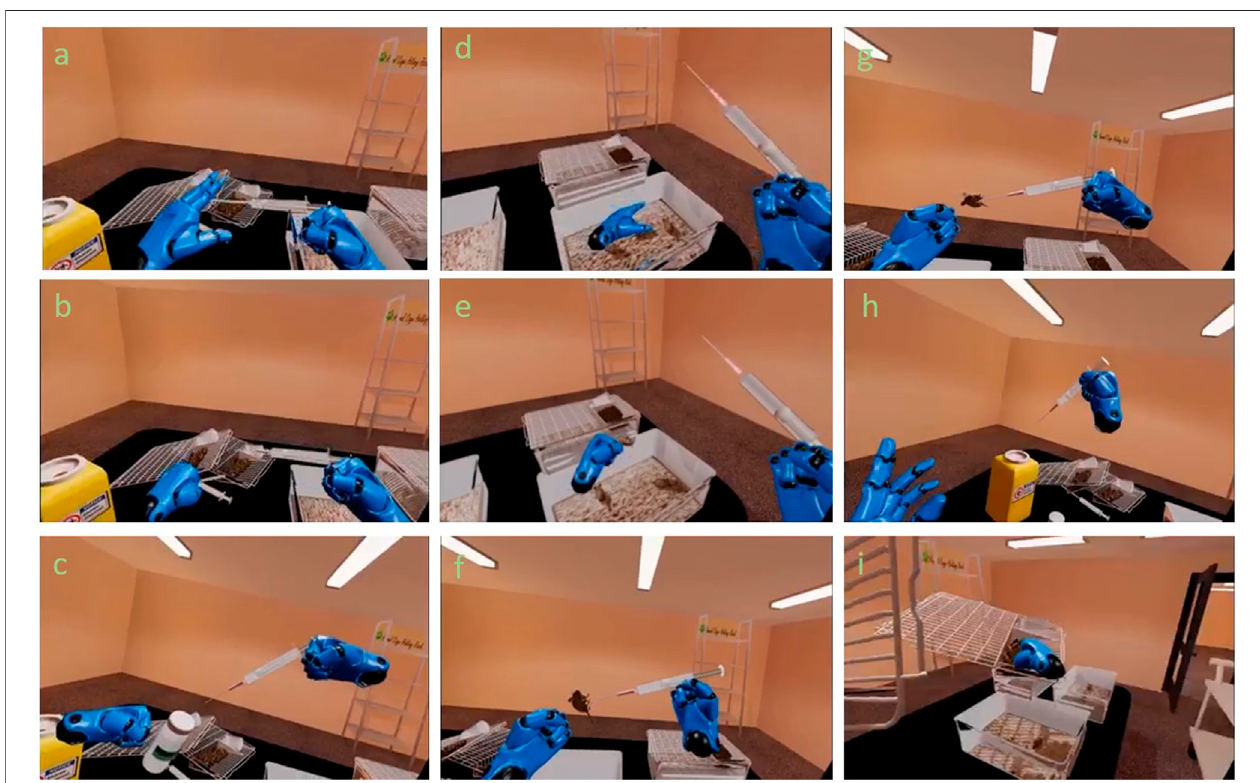
FIGURE 3 | ViSi Game-Mice Injection. The student player was instructed to perform the intraperitoneal injection in the ViSi. (A – C) : After opening the cages, the player took the syringe, removed the bottom cap and aspired to the appropriate volume of drug in the syringe. (D – F) : The player grasped a mouse from the cage, restrained it in a proper position and prepared for the injection process. (G – I) : The player completed the task, put the used syringe into the sharps disposal yellow container and covered the cage.